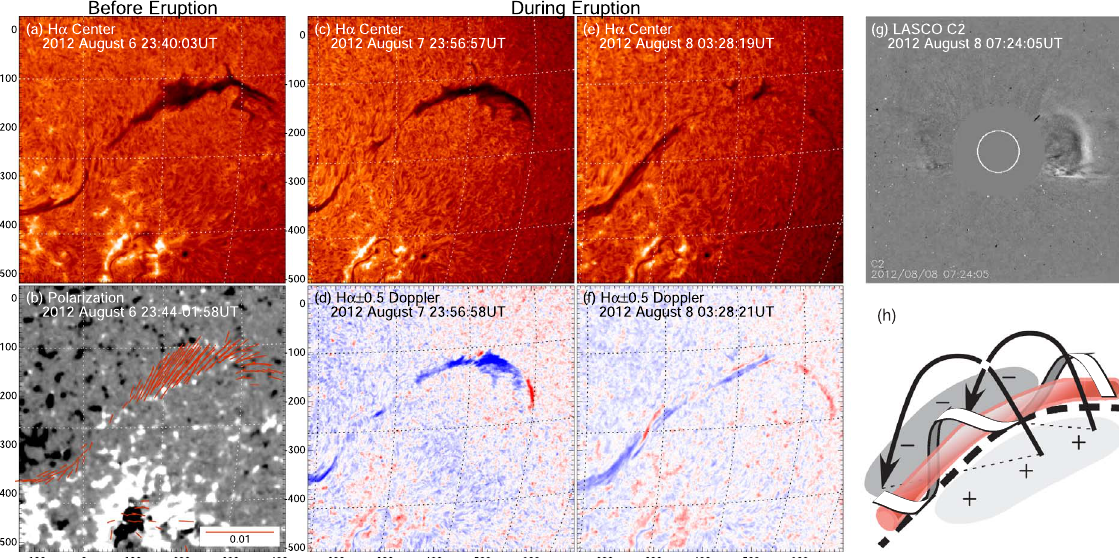
Fig. 5. Filament eruption and accompanied CME occurring during August 6 – 8, 2012. (a) and (b) A H a image and a polarization map including the fi lament before the eruption taken with the SFT. Red lines in panel (b) show the linear polarization of He I 1083.0 nm; the length of each line indicates the degree of the corresponding linear polarization signal (the line in the inset corresponds to the polarization of 0.01 [1%]), and its direction indicates the orientation of the polarization signal. Only the linear polarization signals >0.1% are shown. The background gray- scape map shows the circular polarization of Si I 1082.7 nm, which provides the photospheric longitudinal magnetic fi eld; the display range is ±1%. (c) – (f) The fi lament during its eruption observed with the SFT. Panels (c) and (e) show H a line center images, and (d) and (f) show the Dopplergrams based on the H a ± 0.05 nm images. Blue and red shifts of the H a line are indicated by the corresponding colors. (g) A CME seen several hours after the fi lament eruption observed with the LASCO C2 of SOHO, of which the fi eld of view covers up to 6 solar radii. (h) Schematic representation of the magnetic fi eld structure around the fi lament before its eruption. The red bar represents the fi lament material, and helical magnetic fi eld of the fl ux rope surrounds it. Coronal magnetic loops connect large scale positive and negative polarities on the